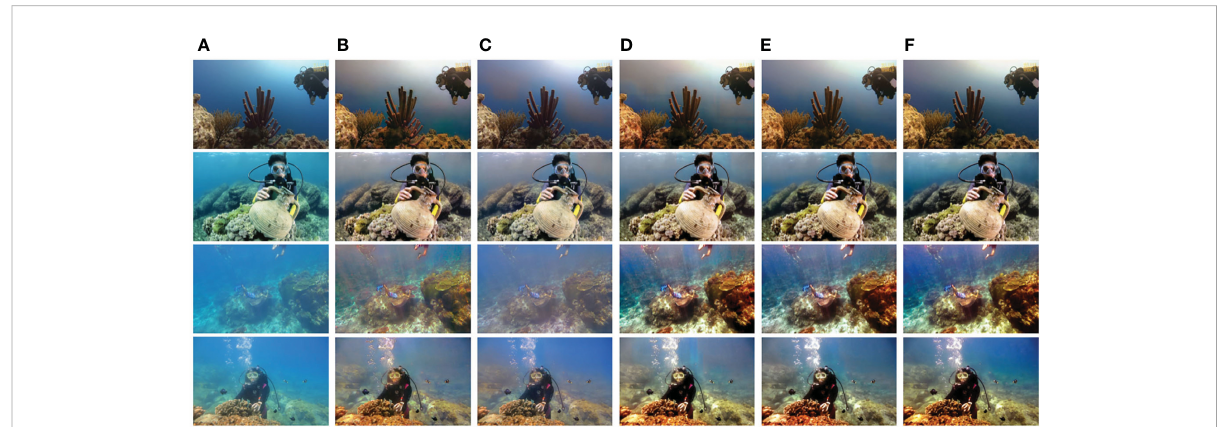
FIGURE 5 The phenomenon of spatially inconsistent styles (w/o RCAB indicates that the proposed model does not use RCAB). From left to right, (A) shows the raw underwater images, (B-F) are the results of UGAN-P (Fabbri et al., 2018), FUnIE-GAN (Islam et al., 2020), Spiral-GAN (Han et al., 2020), w/o RCAB and the proposed model, respectively.